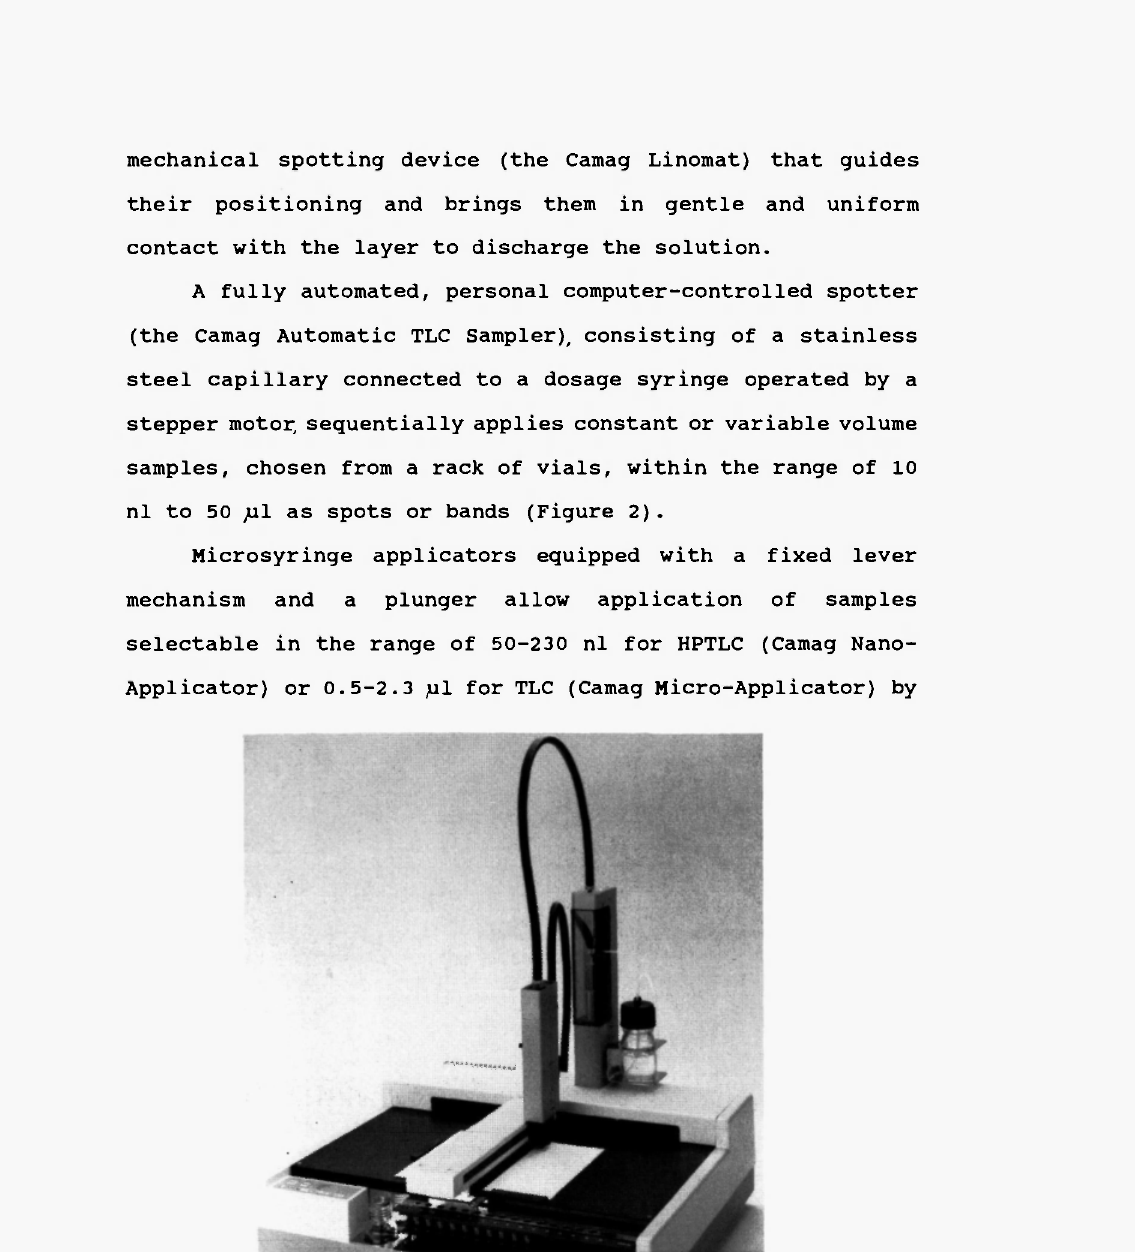
Figure 2. Automatic sample applicator for TLC. (Photograph supplied by Camag Scientific,